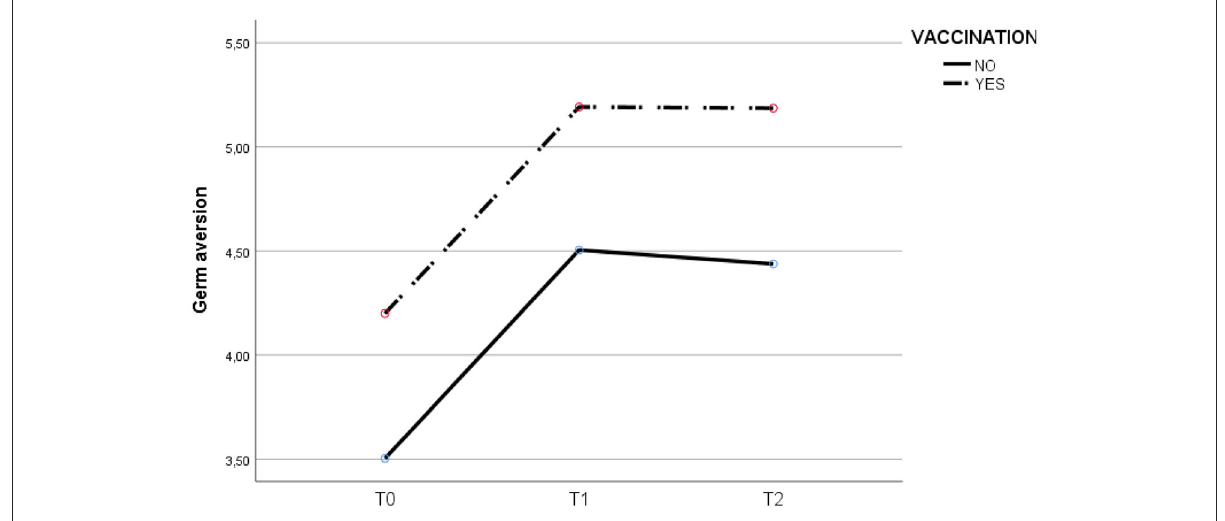
FIGURE2 Evolution of germ aversion at T0, T1 and T2 for vaccinated and unvaccinated.